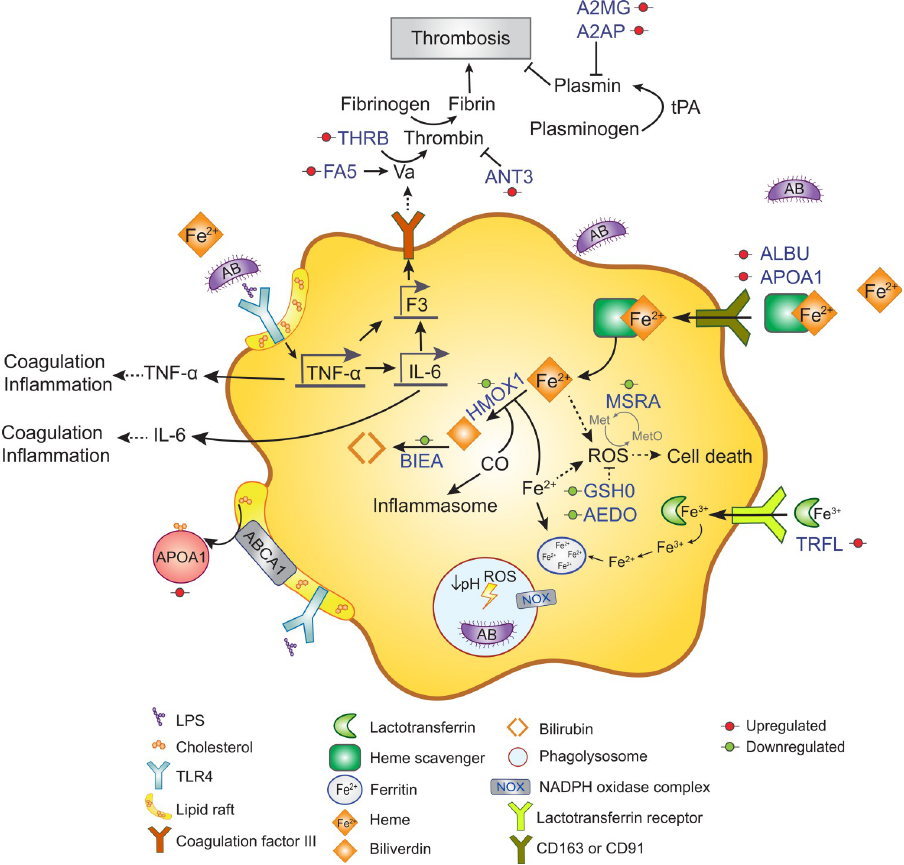
Fig 3. A . baumannii induces the activation of coagulation cascade in infected THP-1-dMs. Schematic diagram illustrating protein networks involved with the coagulation cascade and iron-heme homeostasis in THP-1-dMs infected by AB5075. Red and green circles indicate upregulated and downregulated differentially expressed proteins, respectively. Data are presented as mean of three biological replicates per experimental group.